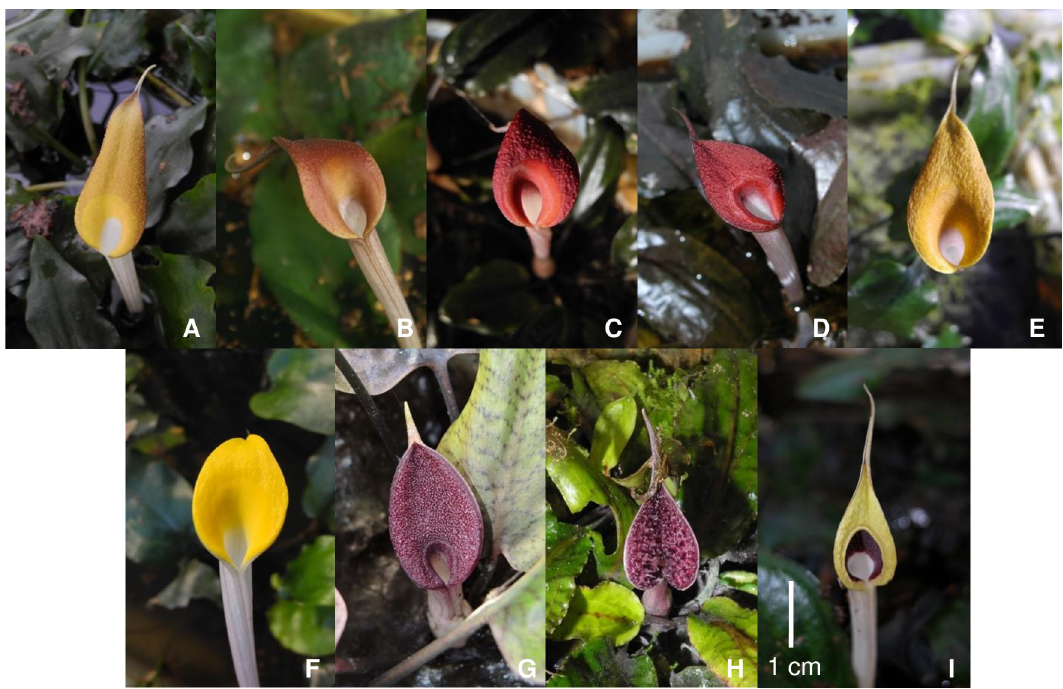
Fig 1. The spathe limbs of different accessions of C . × purpurea nothovar. purpurea and the putative parental species. C . × purpurea nothovar. purpurea (A, MT; B, SU; C, PI; D, SL; E, SED). C . cordata var. cordata (F, BS). C . griffithii (G, GF). C . nurii var. nurii (H, NSK). C . schulzei (I, SPAN). For the locality abbreviations, see Table